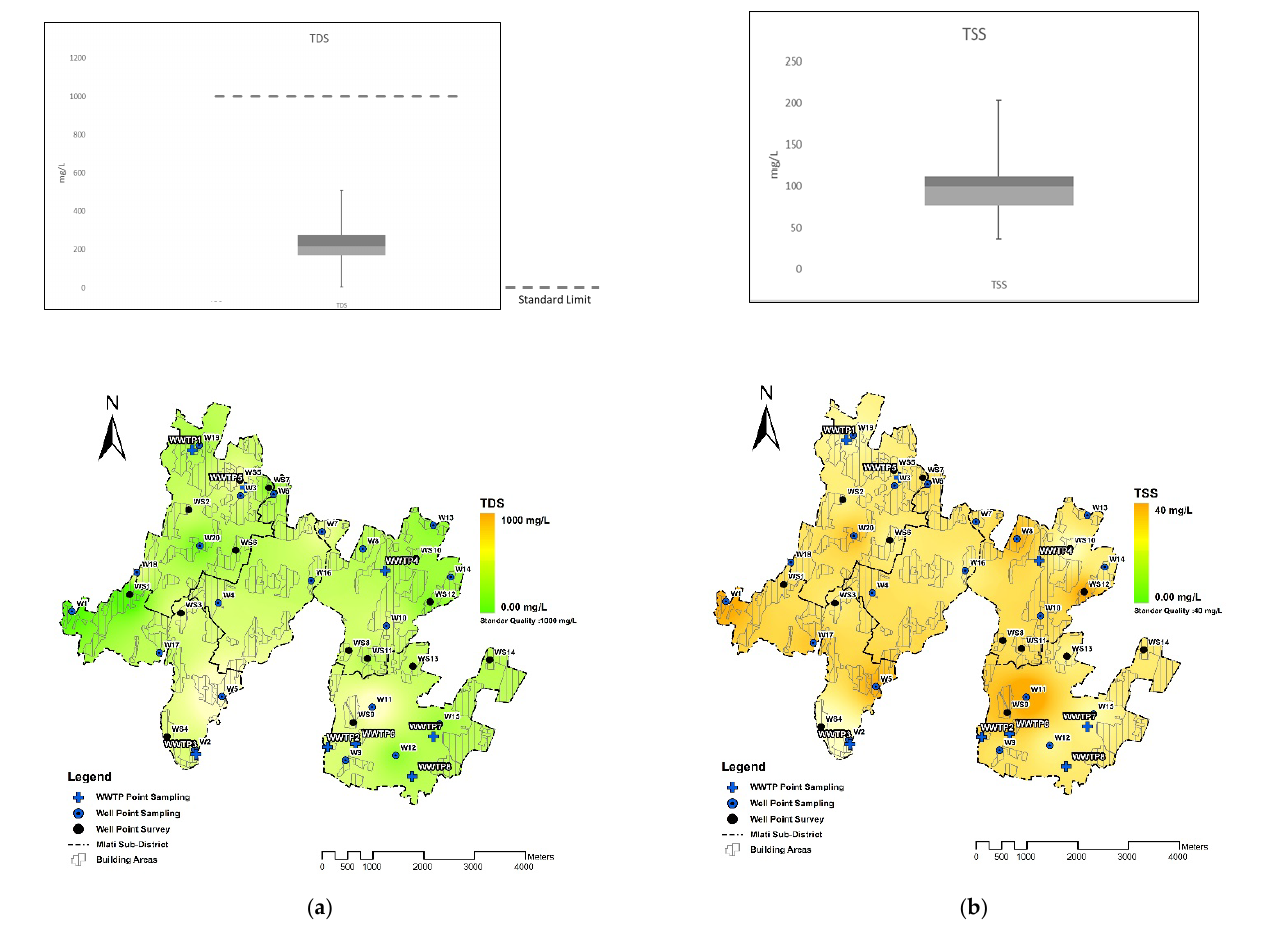
Figure 5. ( a ) TDS and ( b ) TSS concentration and distribution pattern.